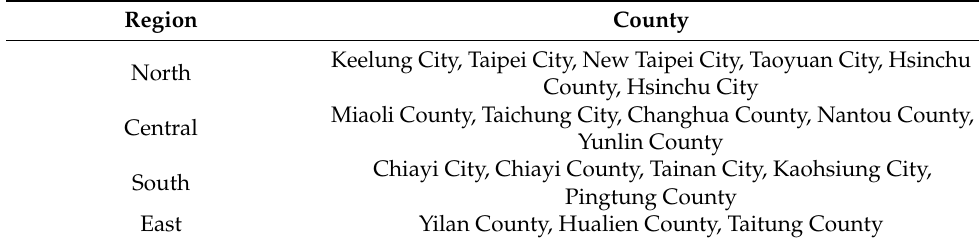
Table 1. Regional counties and cities.